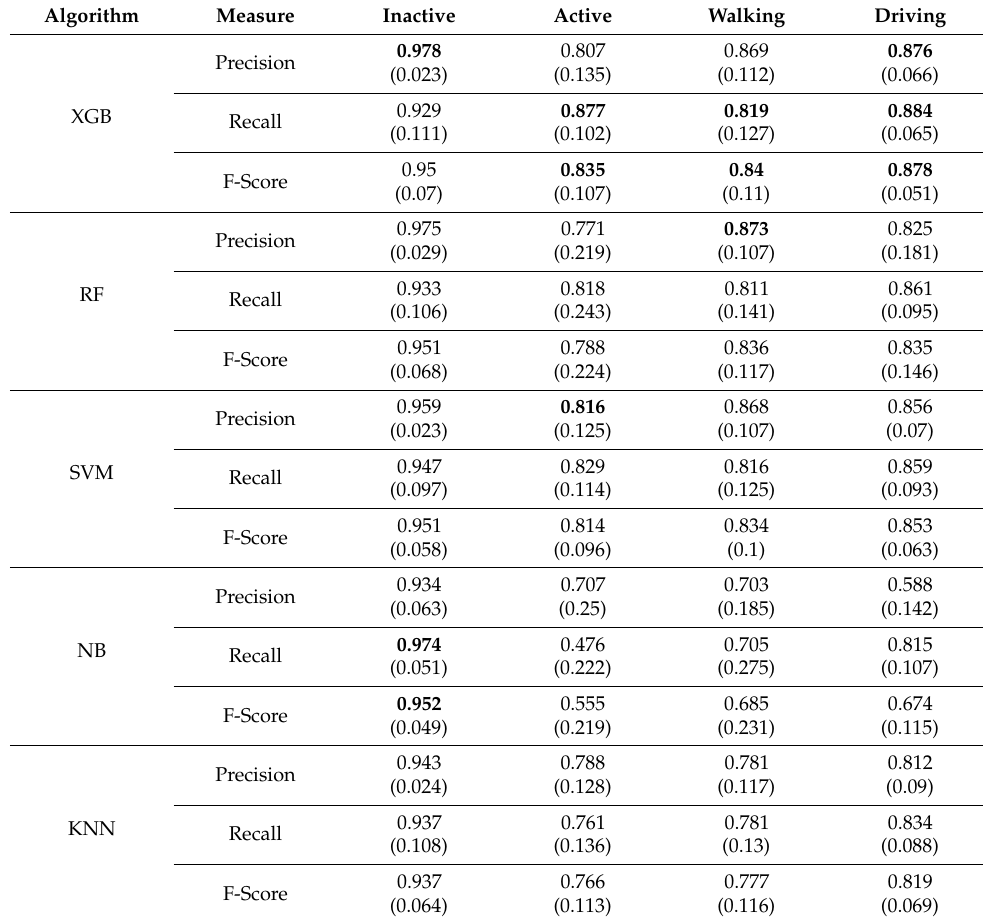
Table 5. Classification results for random stratified data.